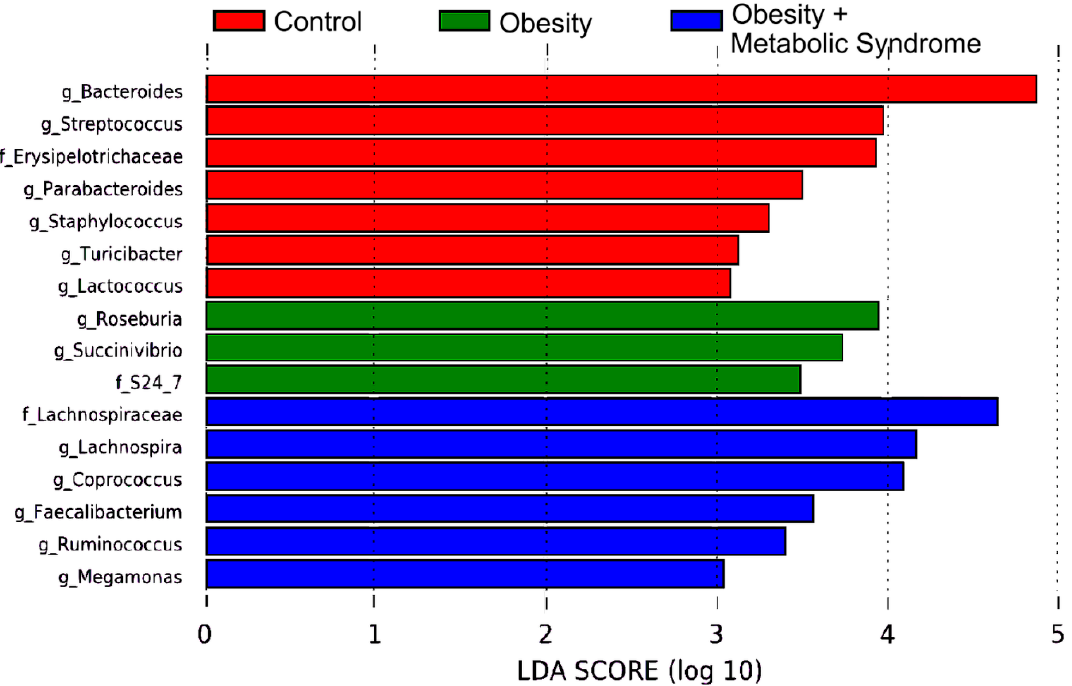
Figure 4. Linear discriminant analysis Effect Size (LEfSe) for the bacterial communities. The LEfSe plot shows enriched bacterial families and genera significantly associated with the three phenotypic categories. Seven bacteria were enriched in the control group (red), three bacteria in the obesity group (green), and six bacteria in the obesity + metabolic syndrome group (blue). The Linear Discriminant Analysis (LDA) score or effect size is shown at logarithmic scale underneath the bars. Each group is identified by color on top of the figure.